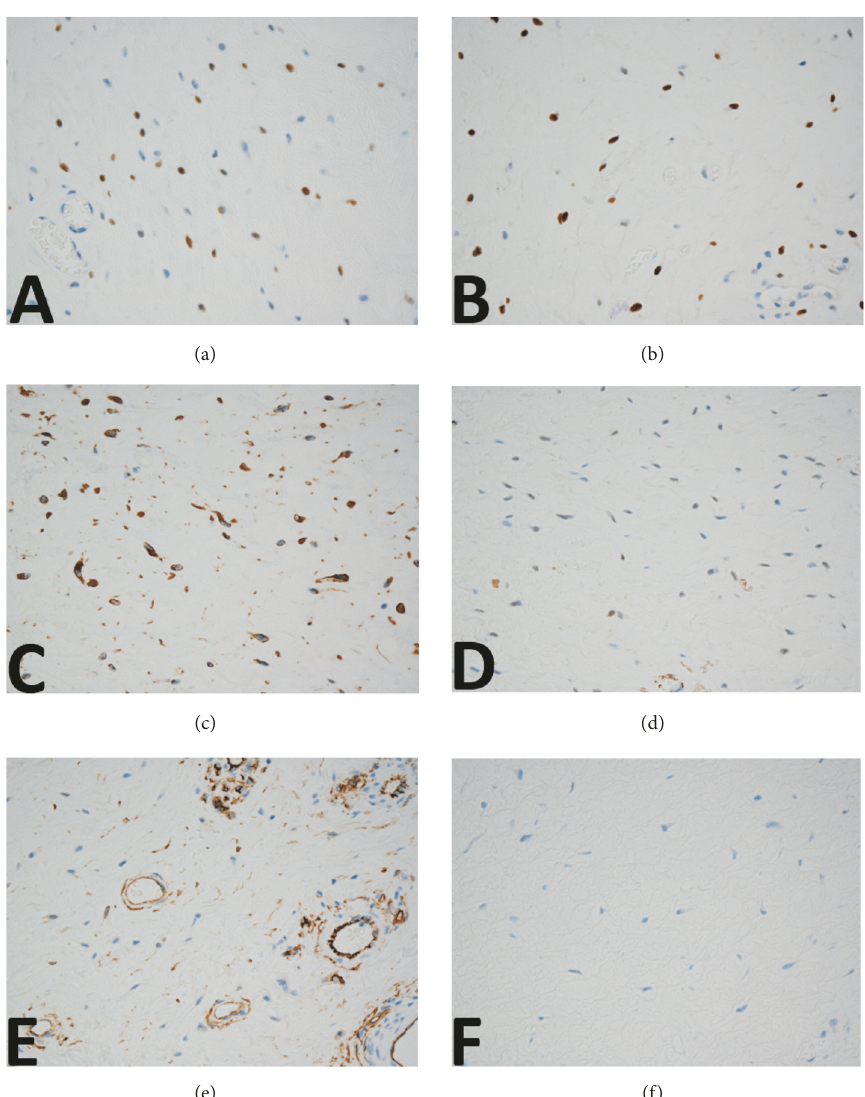
Figure 4: Immunohistochemically, positive nuclear staining for ER (a) and PgR(b) was observed. Tumor cells showed cytoplastic positivity for desmin (c) and 𝛼 SMA (d). CD34 (e) and S100 protein were negative in all cells(f).